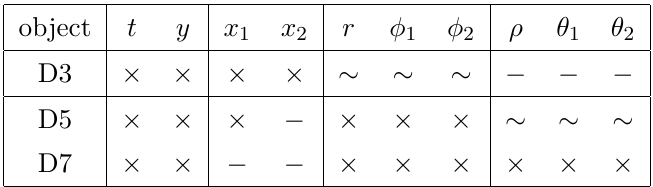
BPS brane system underlying the intersection of D5 – D7 branes intersecting D3 Table 1 . The 1 8 branes. The ∼ denotes smearing